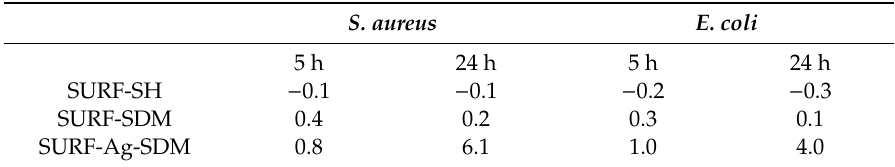
Table 1. Microbicidal e ff ect (ME) values a